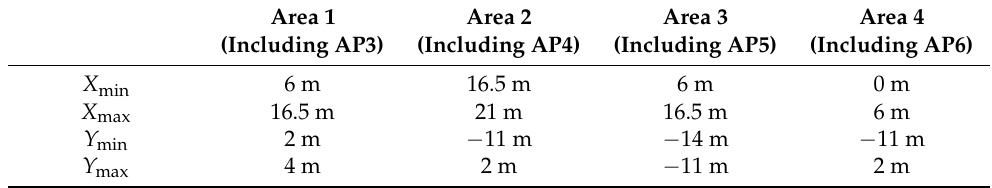
Table 2. Constraint areas in Figure